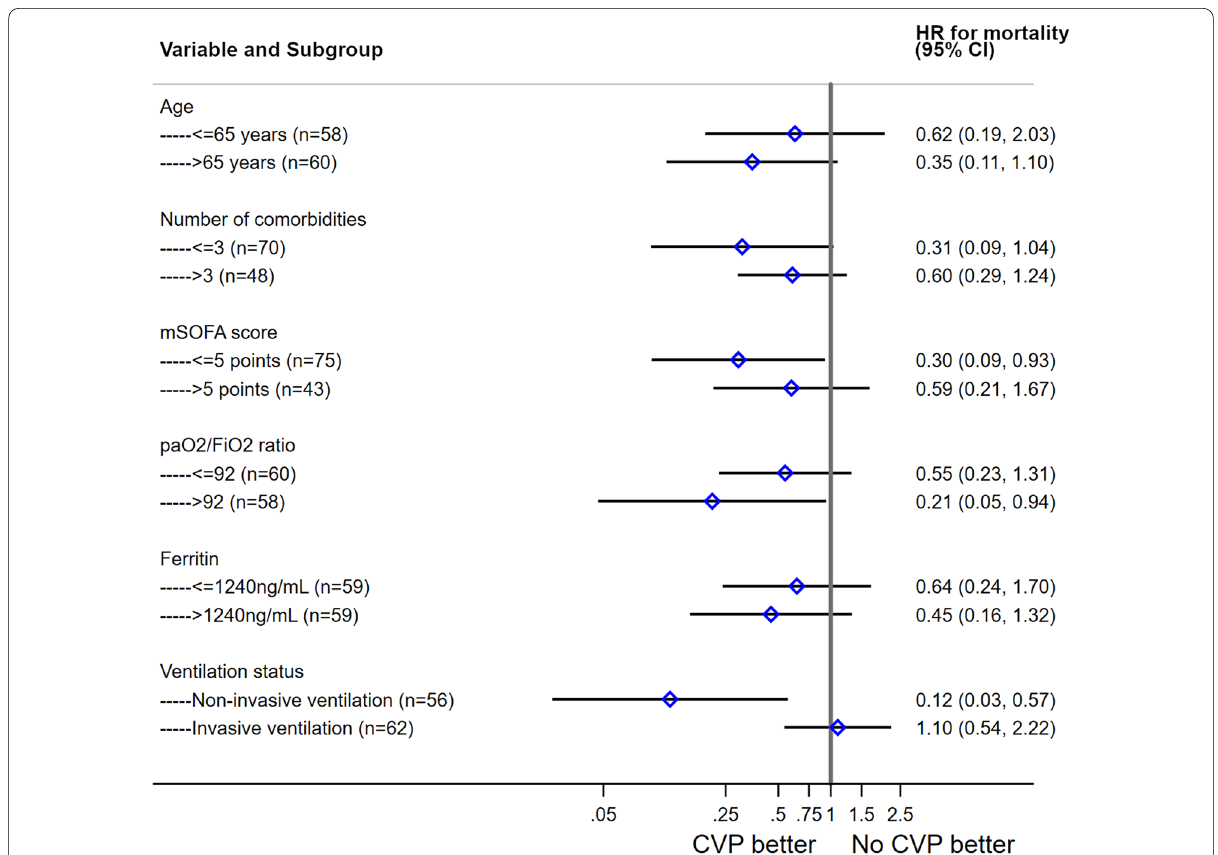
Fig. 3 Subgroup analysis—forest plot of the relative association of CVP with overall survival according to selected clinical co-variables. Hollow-blue diamonds represent the subgroup hazard ratio, and the associated bars the 95% confidence interval. The black vertical line represents the “line of unity”, at which patients who were and were not treated with CVP have similar hazards of overall mortality. Regression results were obtained by fitting an interaction between the CVP treatment and the respective subgroup